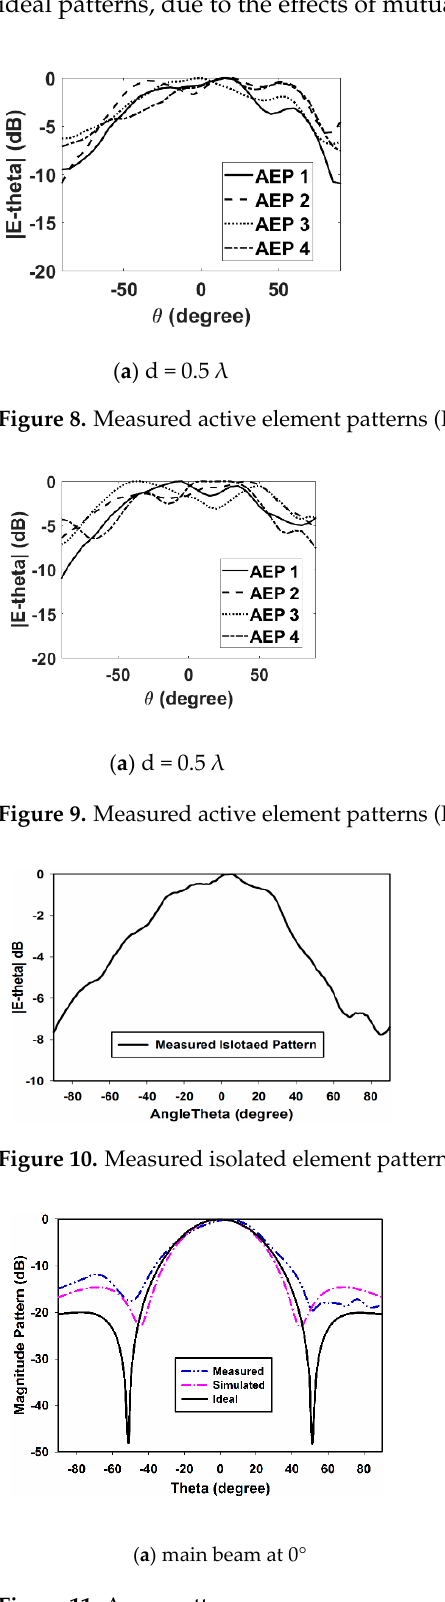
Figure 11. Array Figure 11. Array pattern. Figure 11. Array pattern. Figure 11. Array pattern.